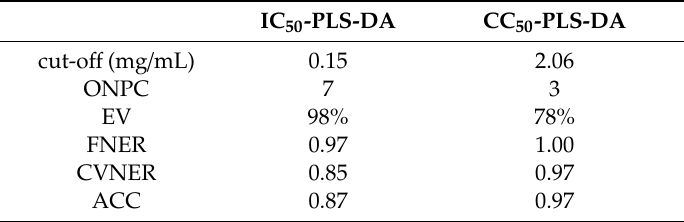
Table 3. Cross-validation scores for the binary PLS-DA classification models built with di ff erent cut-o ff